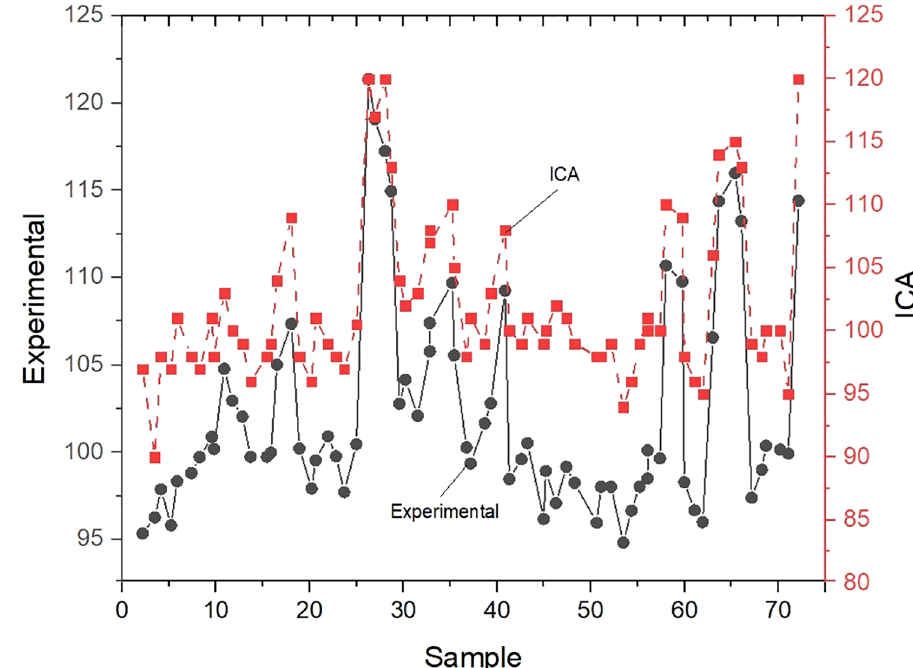
Fig. 10 Comparison between the imperialist competitive algorithm data and the real data in the hardness